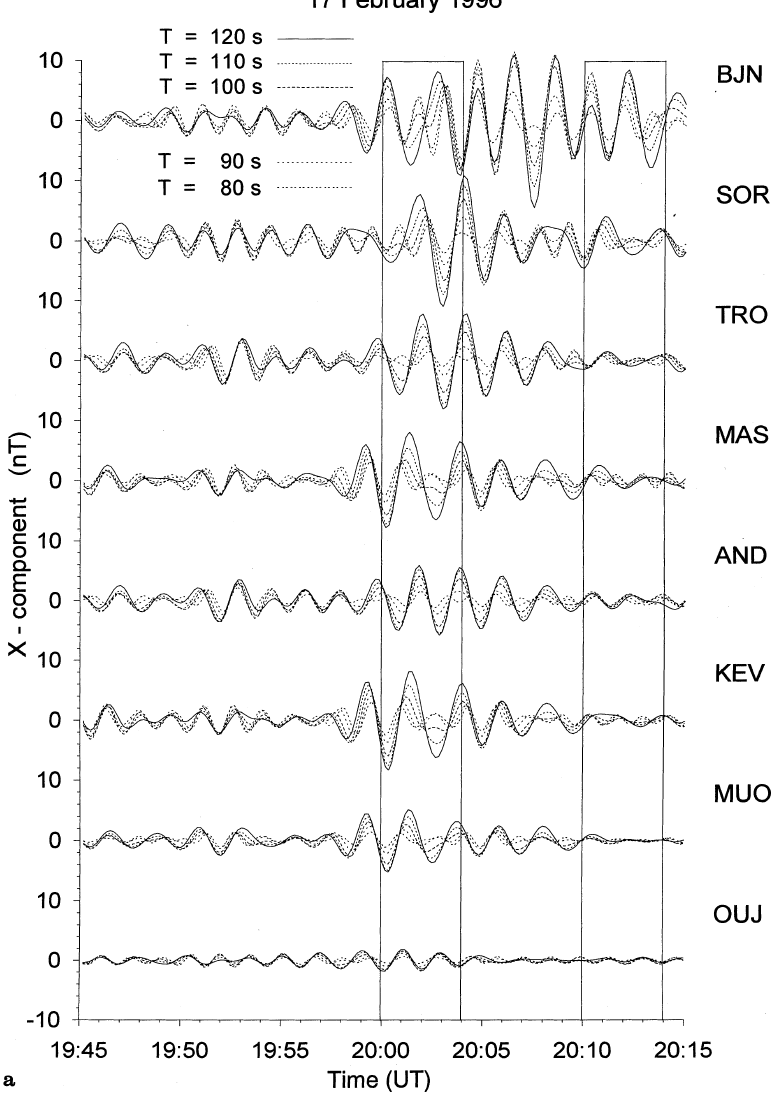
Fig. 6a, b. Magnetic field variations from eight IMAGE magnetometer stations, bandpass filtered between 120 and 80 s for a the X component and b the